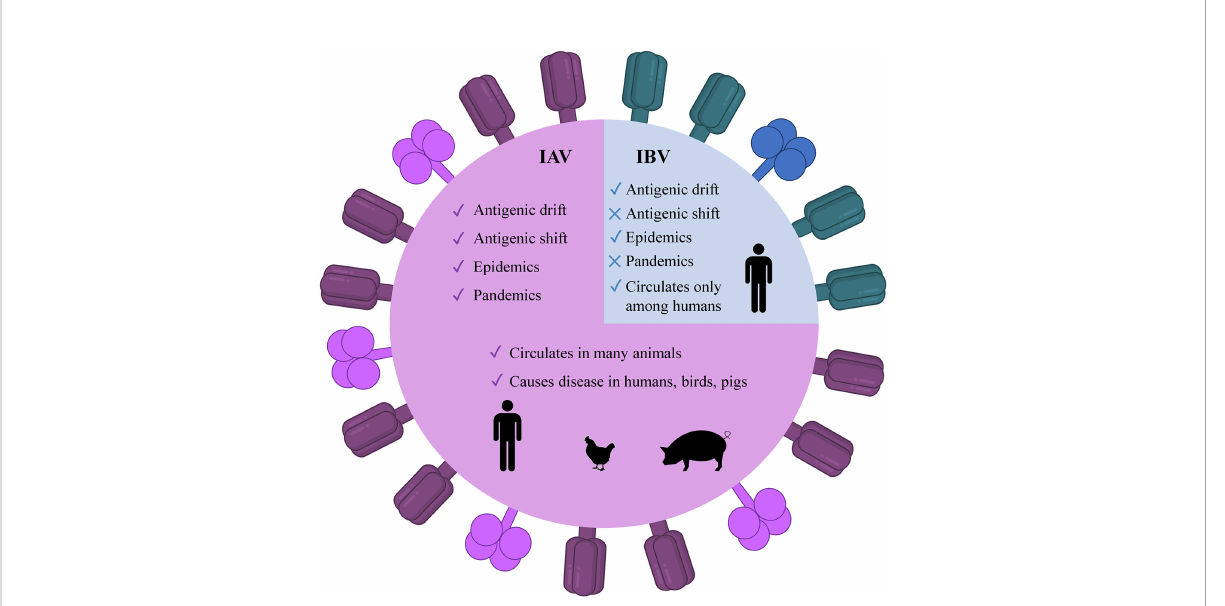
FIGURE 1 Illustrated schematic differences between IAV and IBV. The trimeric HA (deep purple) and tetrameric NA (magenta) are present as protruded glycoproteins. IAV, in fl uenza A virus; IBV, in fl uenza B virus, HA, hemagglutinin; NA,